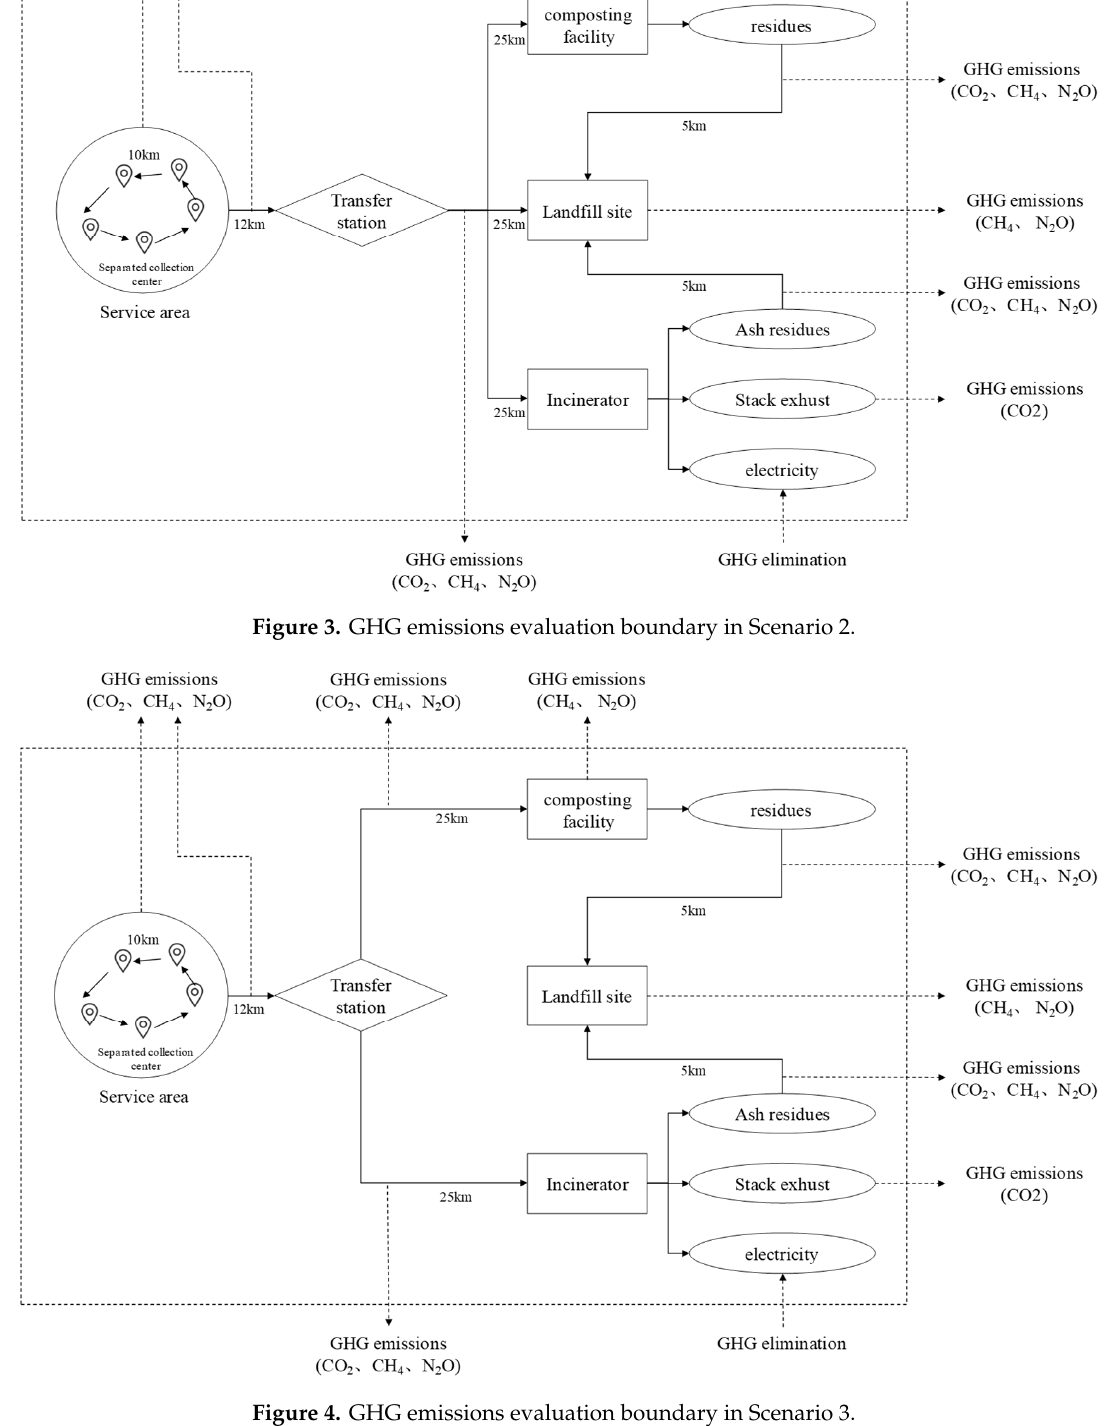
Figure 4. GHG emissions evaluation boundary in Scenario 3.